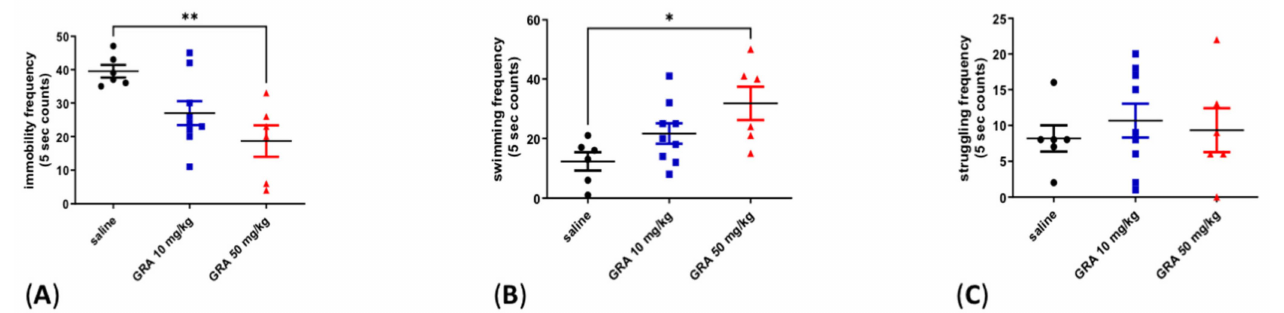
Figure 1. Effect of GRA administration in the FST in naïve rats. Effect of GRA administration on immobility ( A ), swimming ( B ) and struggling ( C ) frequencies in the FST in rats treated (i.p.) with saline (n = 6, black dots), GRA 10 mg/kg (n = 9, blue dots) and GRA 50 mg/kg (n = 6, red dots). * p < 0.05, ** p < 0.01 GRA 50 mg/kg vs. saline. One-way ANOVA followed by Tukey’s post hoc test.